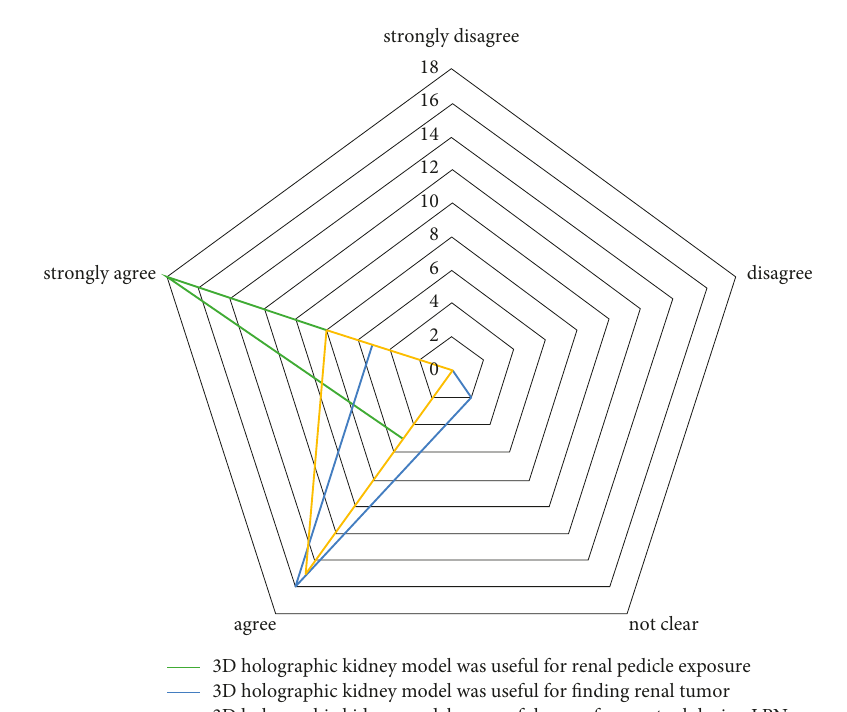
Figure 5: Radar chart for questionnaire answer